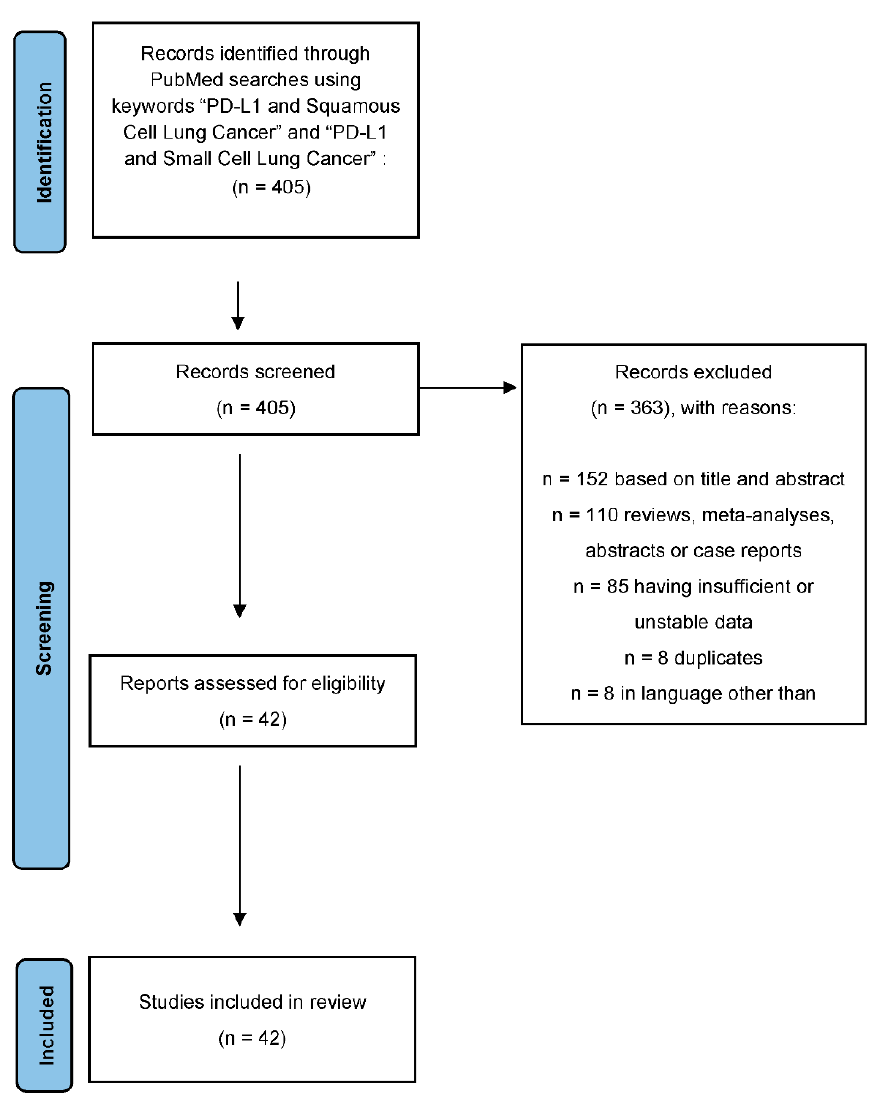
Figure 1. Consort diagram of the study process using Prisma protocol. Note: cut-off of 1–49% includes studies that used unique criteria to determine positivity, such as >5% staining or minimum moderate intensity staining.